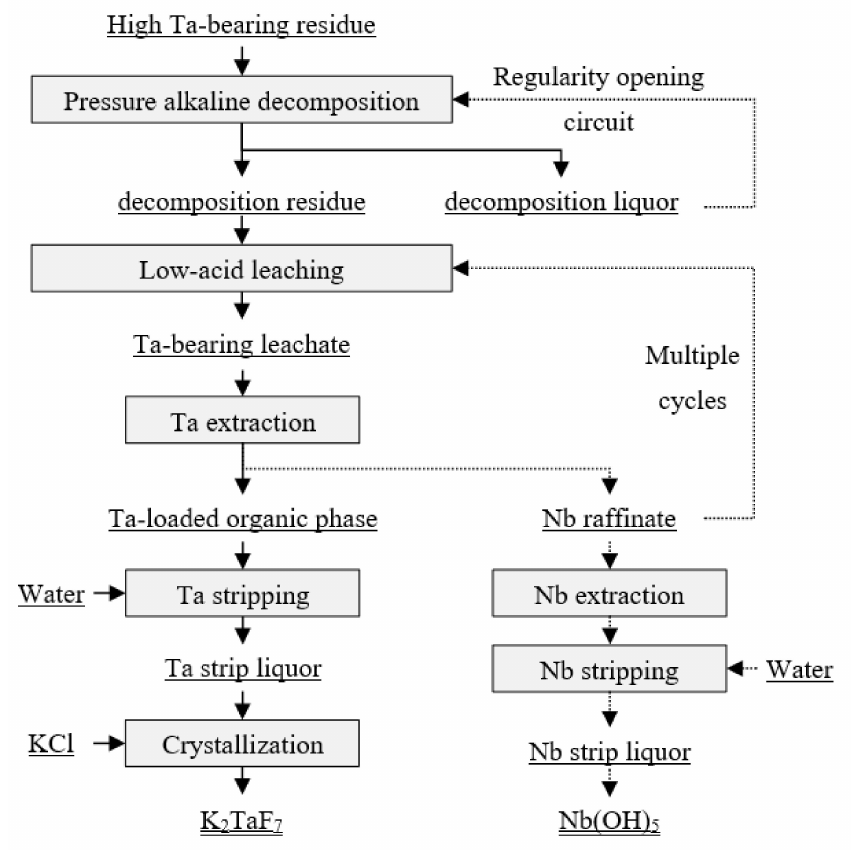
Figure 2. The process for recovery of tantalum slag by pressurized alkali